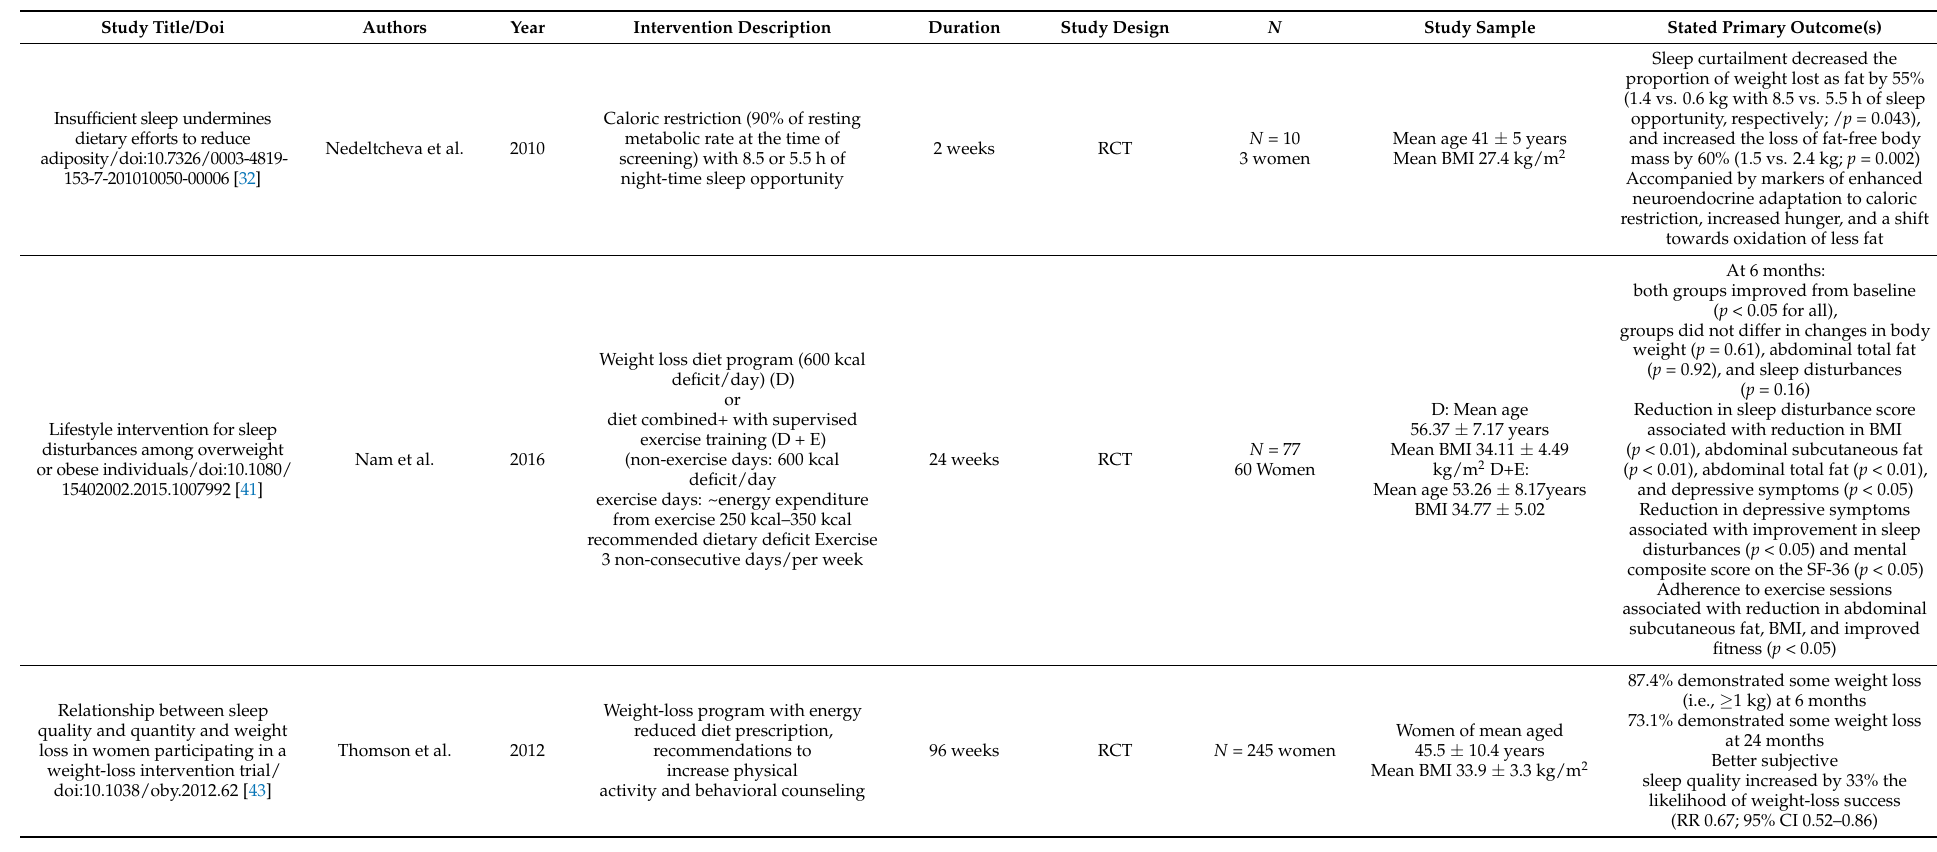
Table 1. Studies on sleep deprivation and weight